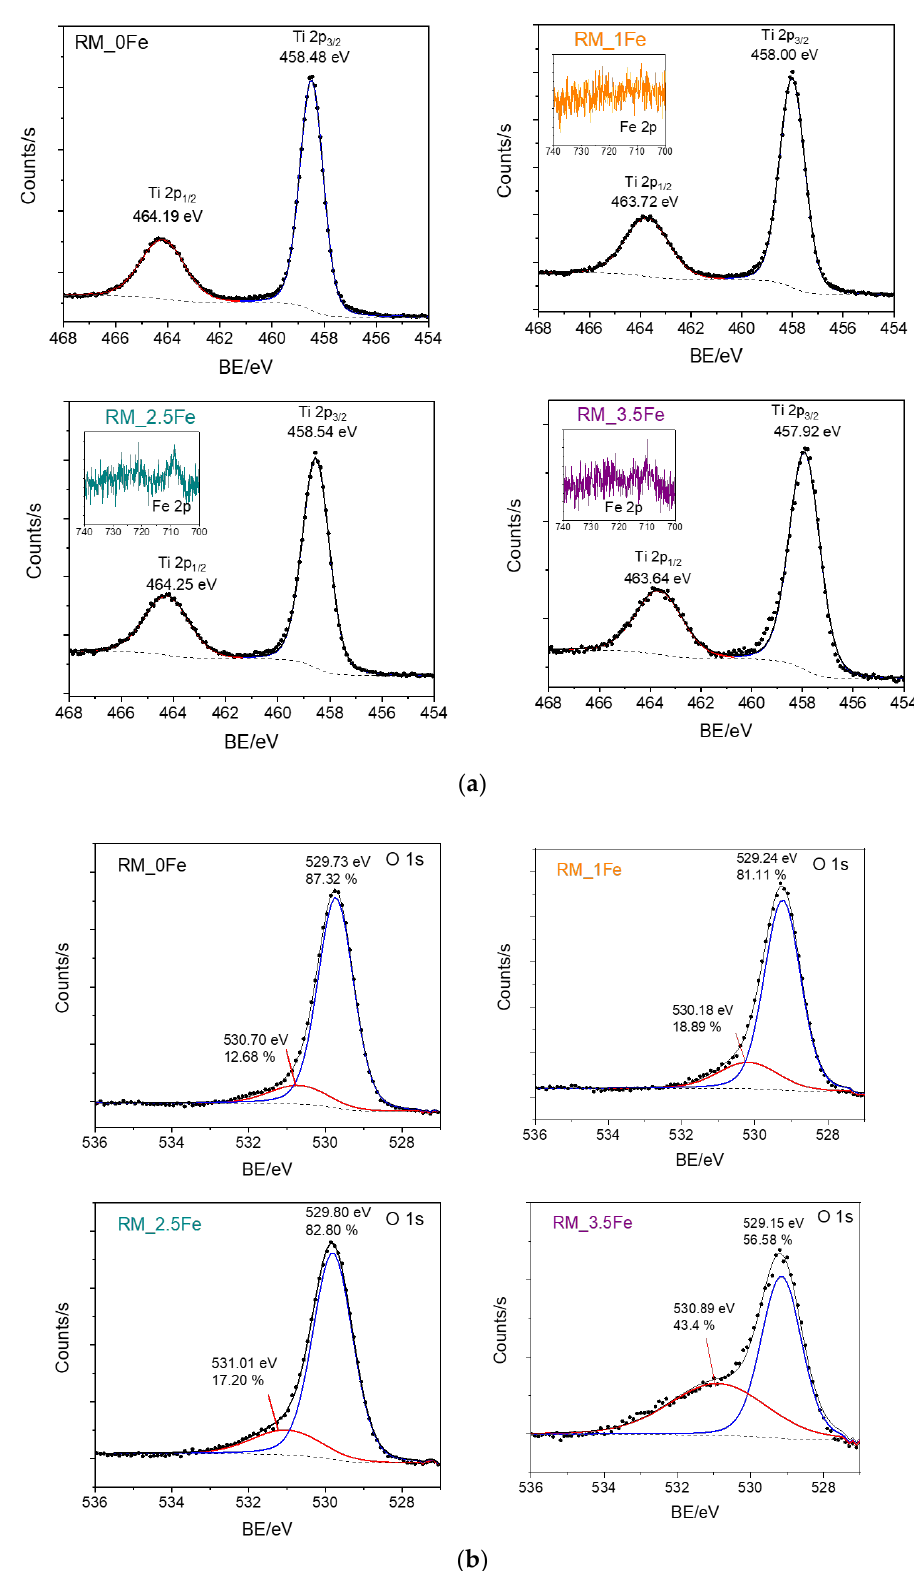
Figure 7. HR XP spectra concerning the Ti 2p line ( a ) and the O 1s line ( b ) of the studied powder samples. Insets of Section show a concern the Fe 2p line measured with Fe-doped samples, namely RM_1Fe, RM_2.5Fe and RM_3.5Fe.